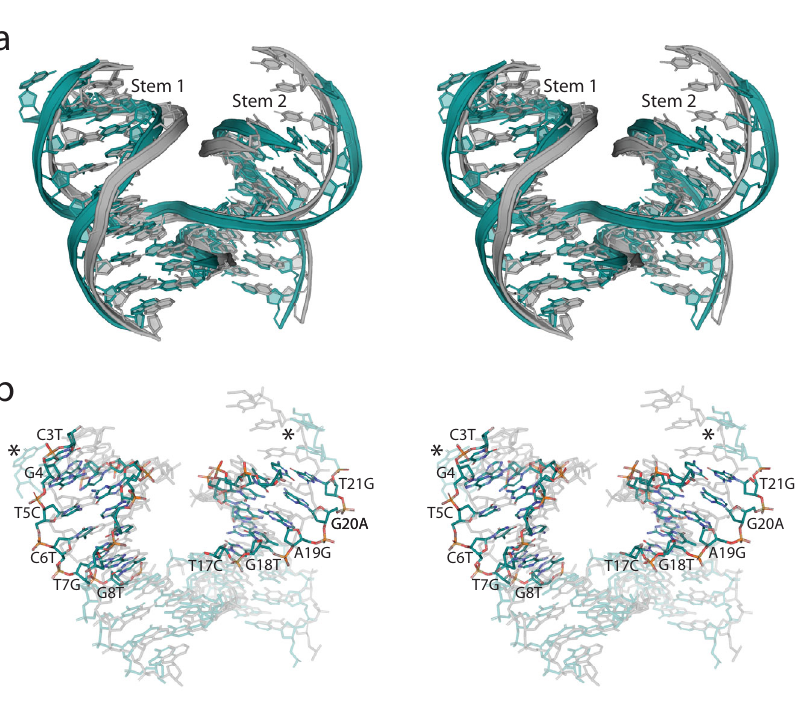
Fig. 3 Stem sequence perturbations alter junction angles and in fl uence global symmetry. a Stereoview of a superposition of the J10 junction structure using the original 4 × 6 sequence motif with P 3 2 symmetry (gray), with the scrambled sequence version containing R 3 symmetry (teal). The modi fi ed sequences were located within the two downstream stem (1 & 2; indicated) regions containing the same GC content as the original 4 × 6 sequence version. The effect of the scrambled sequence on the geometry of the junction is visually apparent when comparing the superimposed Stem 1 & 2 regions. The dramatic difference in junction angle, and its in fl uence on symmetry is evident (Supplementary Fig. 15). b Stereoview of a stick representation of the superimposed J10 structures in ( a ) with all base modi fi cation sites between the original and scrambled sequence version of the 4 × 6 J10 structures are indicated in Stems 1 & 2. Asterisks are included to provide attention towards the sticky end regions that signi fi cantly diverge as an apparent result of the angles induced by the modi fi ed stem sequences. Atoms are indicated using the following: carbon (teal), nitrogen (blue), oxygen (red), and phosphate (orange). All regions containing identical sequence are left